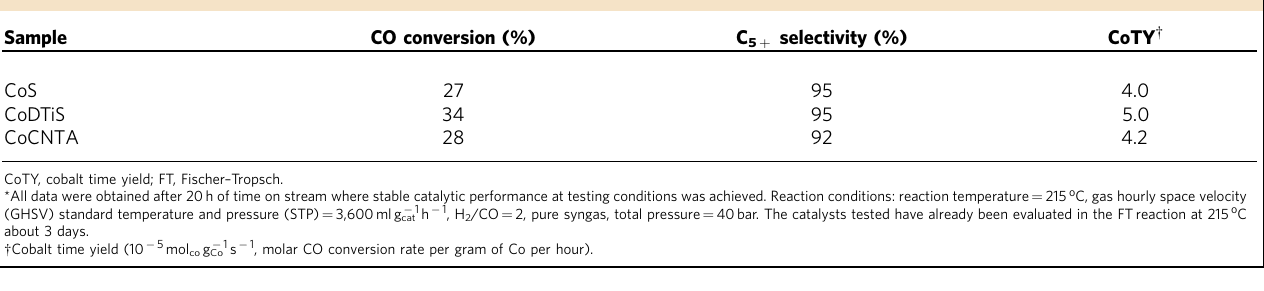
Table 1 | Comparison of the FT catalytic performance of various cobalt-based catalysts*. Sample CO conversion (%) C 5 þ selectivity (%) CoS